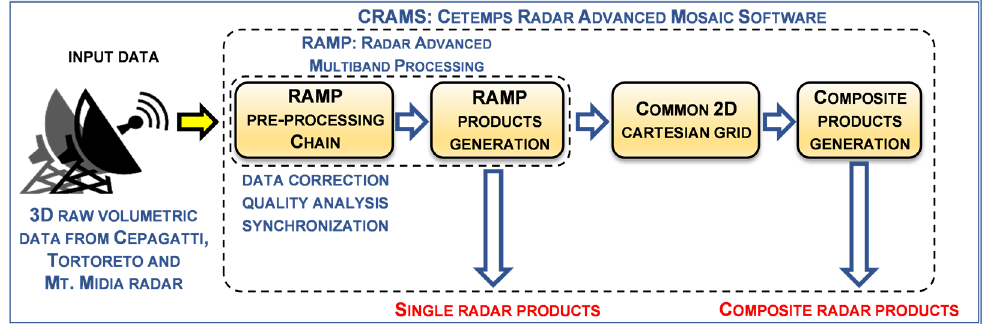
Figure 4. Overview of the CRAMS chain flowchart: all data are collected every 10 min and synchronized, and the related composite products are generated in real time as output maps.